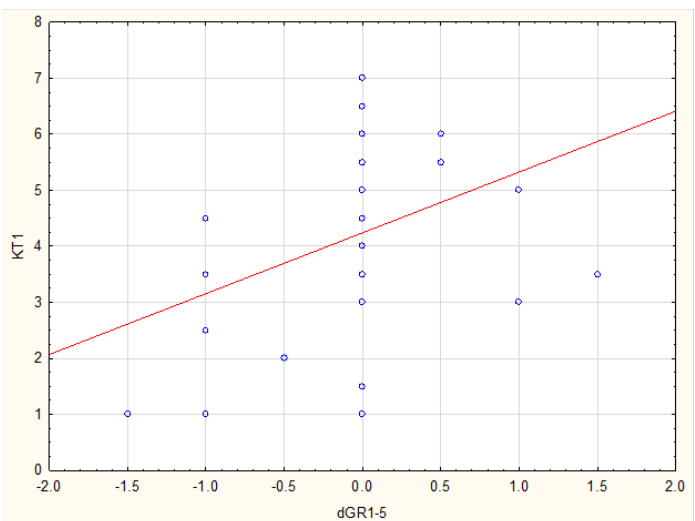
Figure 3. Correlation between KT width one year after procedure and GR changes between examination after one year and five years on the SCTG side.